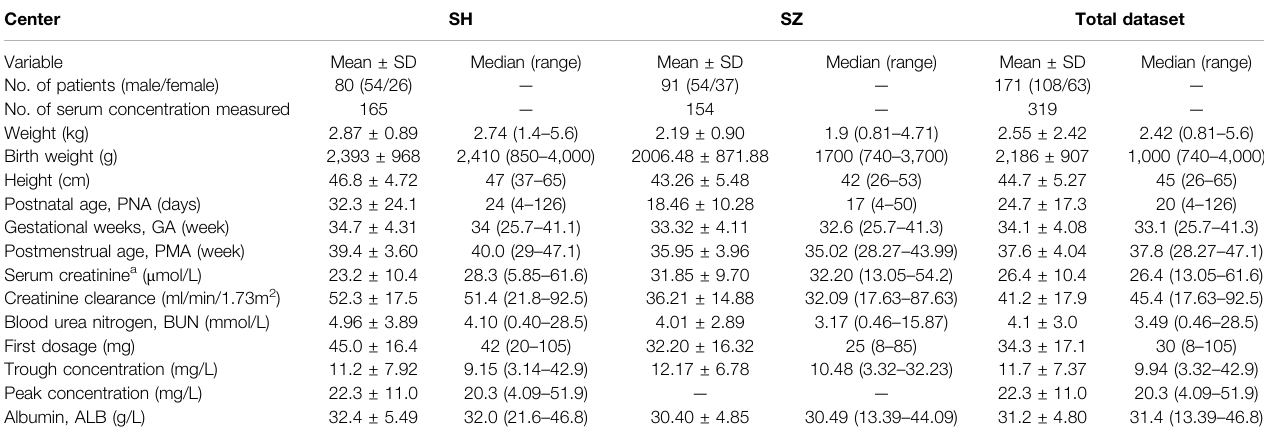
TABLE 3 | Neonatal characteristics in external evaluation